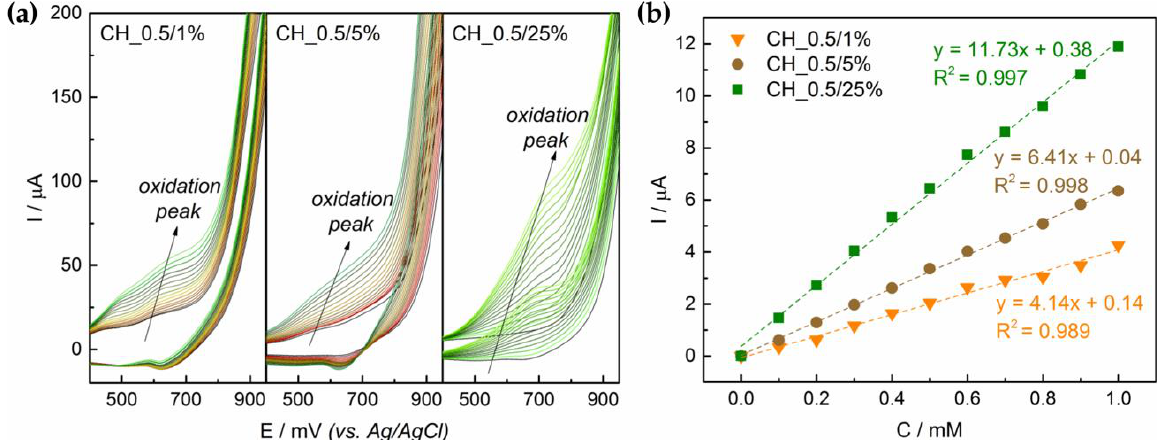
Figure 5. Electrochemical performance of the electrodes based on CH_0.5/1%, CH_0.5/5% and CH_0.5/25% suspensions: ( a ) voltammograms for glucose concentration range 0−1.5 mM; ( b ) regression lines glucose concentration versus generated current (step 0.1 mM).